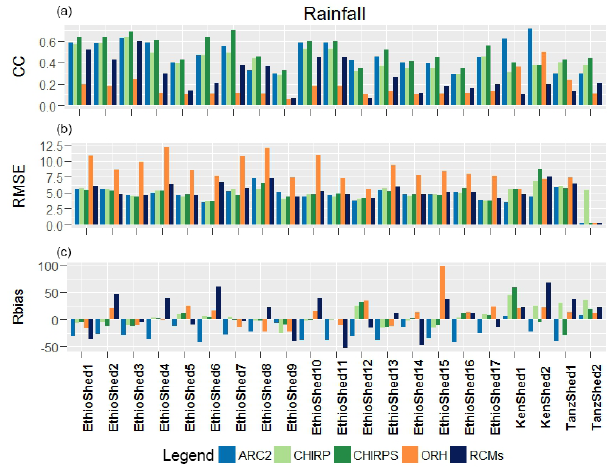
Figure 4. Statistical evaluation of daily T max retrieved from GFDL, HadGEM2, MPI, ORH, and RCMs against ground observations: CC (a) , RMSE (b) , and R bias (c) over the period of 1983–2005 for 21 validation areas of East